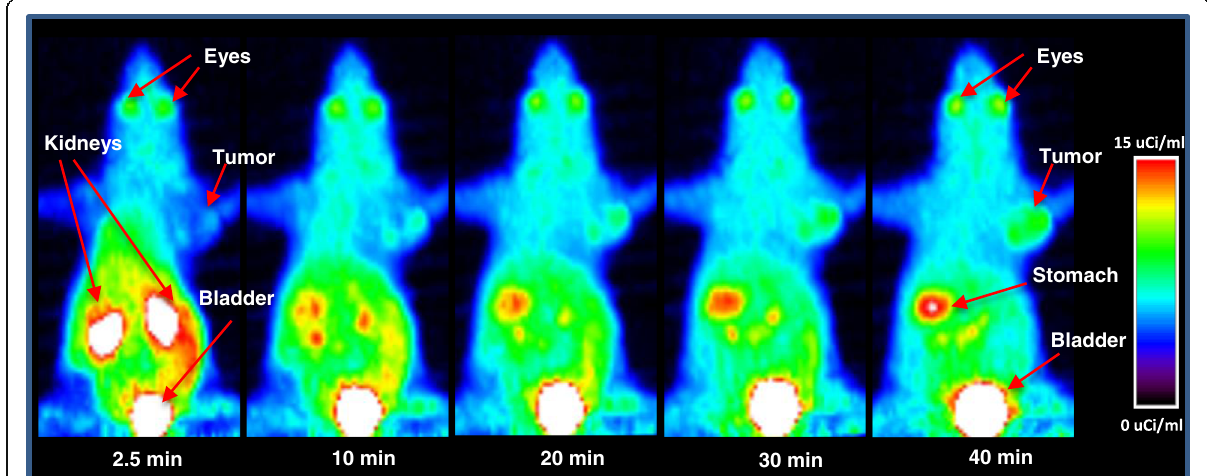
Fig. 9 Maximum Intensity projection (MIP) images from MicroPET scans of a mouse bearing B16F1 melanoma tumors xenograft that was injected with ~284 μ Ci of 4-[ 18 F]FEBZA. These MIP images show radioactivity accumulation at 2.5, 10, 20, 30, and 40 min post-injection. Uptake in eyes was quite prominent as early as 2.5 min post-injection. The kidneys show an intense accumulation of radioactivity within 2.5 min post-injection followed by a rapid clearance thereafter. The tumor is clearly visible by 10 min post-injection and the uptake intensity in tumor continued to increase with